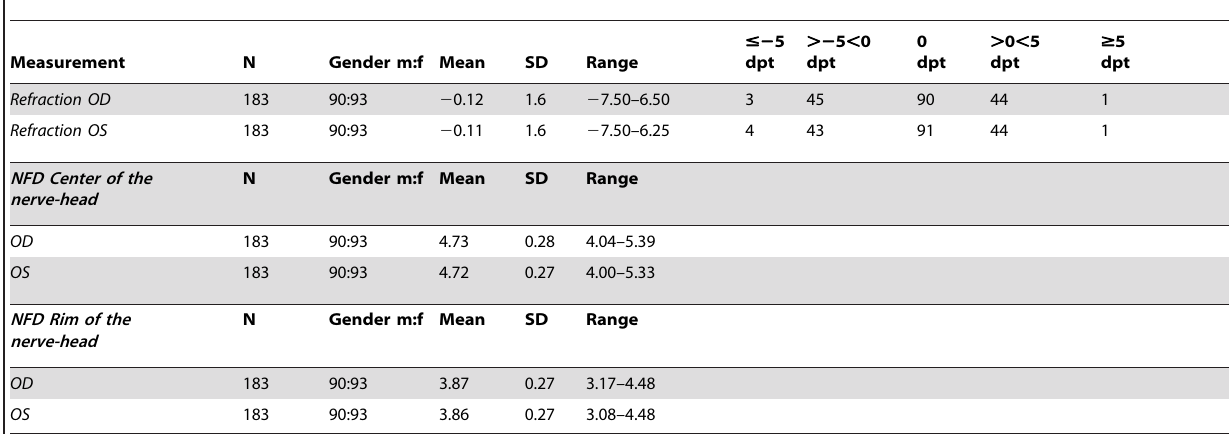
Table 1 . Characteristics of study population (n=183); Gender, mean, standard deviations (SD) and range for refractive errors in diopters (dpt) and nerve-head to fovea distance (NFD) measured from the rim and the center of the nerve-head in 183 right eyes (OD) and left eyes (OS) in